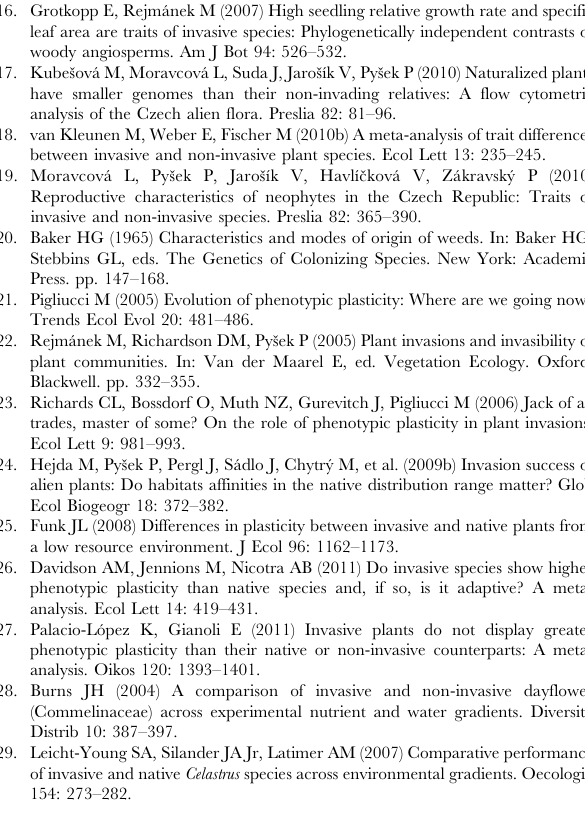
Figure S4 Comparisons of stem height of I. capensis (A), I. glandulifera (B), I. noli-tangere (C) and I. parviflora (D) in the second experiment. The effect of intra- and interspecific competition on stem height is visualised with the species used as the intraspecific competitor placed first on x-axis (A: C, Impatiens capensis; B: G, I. glandulifera; C: NT, I. noli-tangere; D: P, I. parviflora), and the interspecific competitors as the further three species on x-axis. Treatments are ignored if the highest level interaction for the analysed subset of the data was significant and the model thus could not be further simplified for the individual levels of the factors. Otherwise, the species are evaluated separately for each level of each factor that appeared significant. In case of significant interactions between the treatments, the pattern of bars differs for each level of each treatment. Bars of mean species values whose 95% least square differences (LSD) intervals do not overlap are significantly